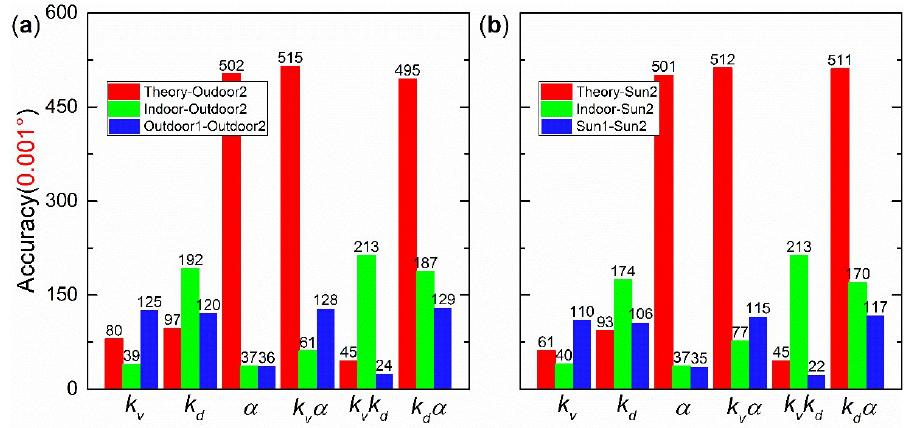
Figure 24. Outdoor replacement results without replacing k : ( a ) The compensation is not done; ( b ) the compensation is done.